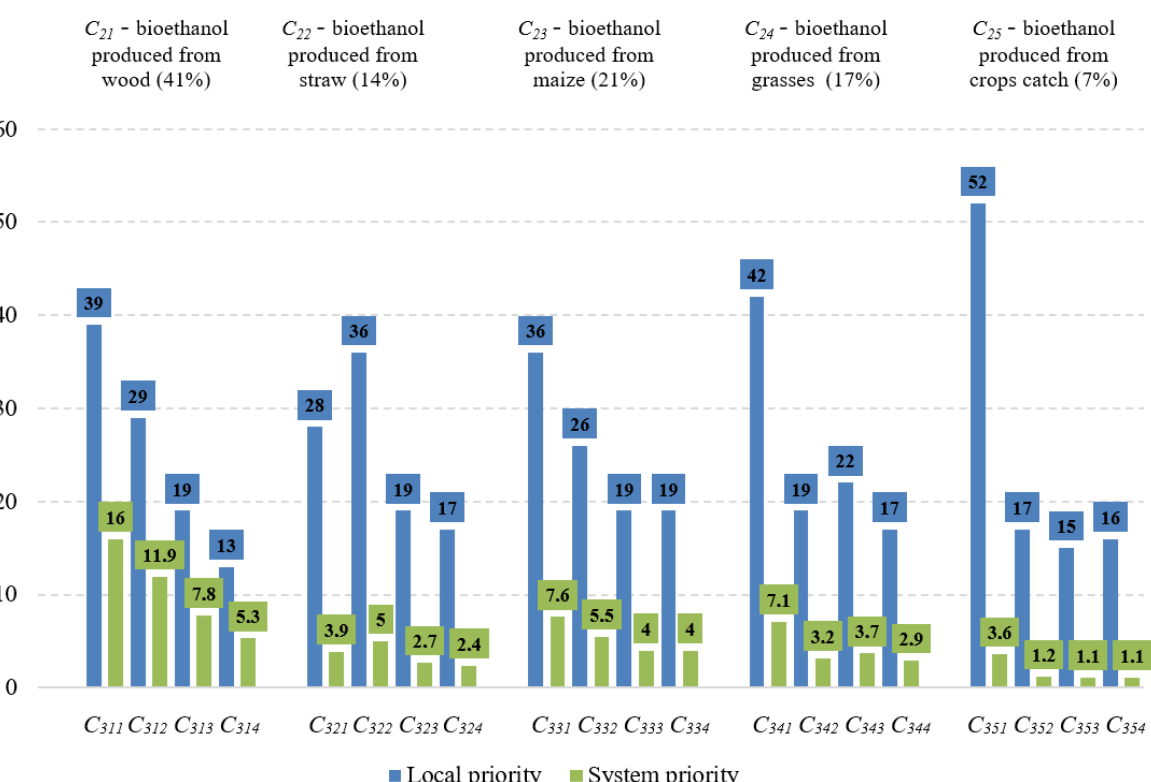
Figure 5. Assessment of the significance of level III factors conditioning the development of second- generation bioethanol production in Poland. Local priorities were determined, characterizing their significance in the given study group in level III factors (shown in blue bars). For each factor, system priority values were determined, which denoted their share in the hierarchy of significance of the main objective (shown in the green bars). The system priority value was calculated by multiplying the value of the local priority at a given level of the factor by the value of the local priority of the higher-level factor located in the given branch of the event tree. Table 3. Significance rank of level III